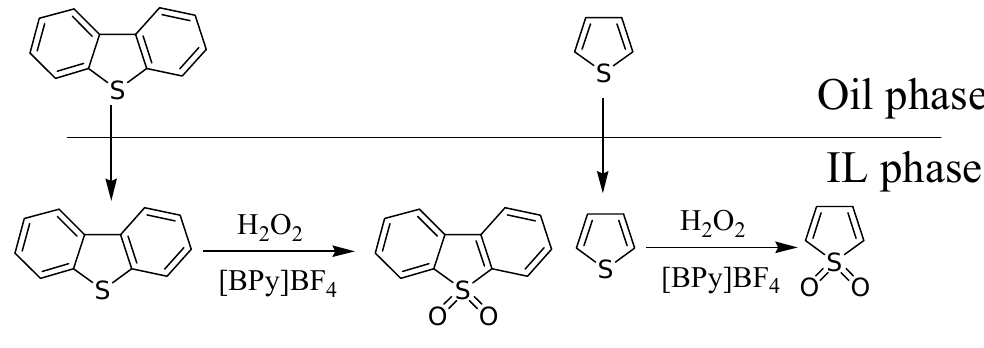
Figure 2. Process of extraction-oxidation of thiophene and DBT in model oil by IL- H